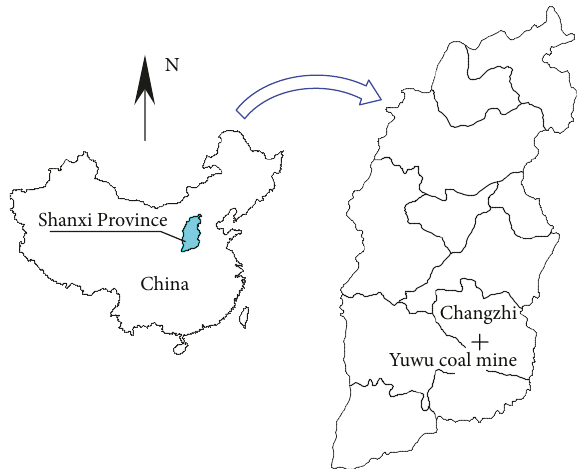
Figure 3: Location of Yuwu coal